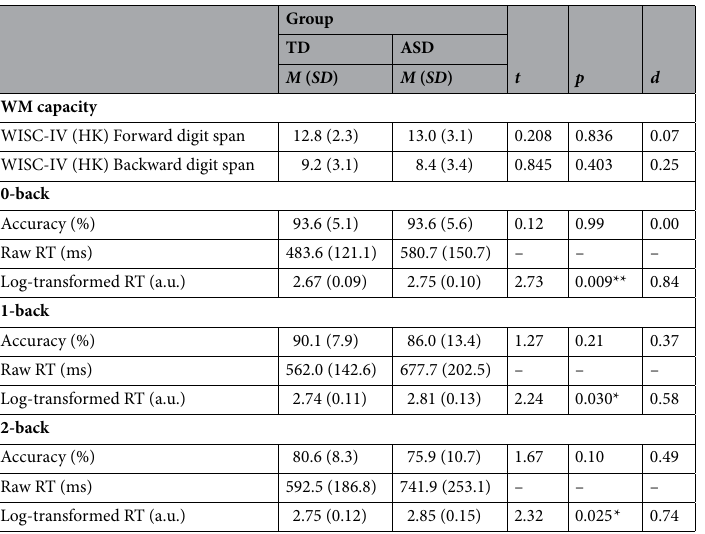
Table 2. Working memory performance of TD (n = 24) and ASD (n = 22) individuals in our sample. WISC- IV(HK), Hong Kong version of the Wechsler Intelligence Scale for Children-Fourth Edition short form; WM, working memory. *p < .05, ** p <